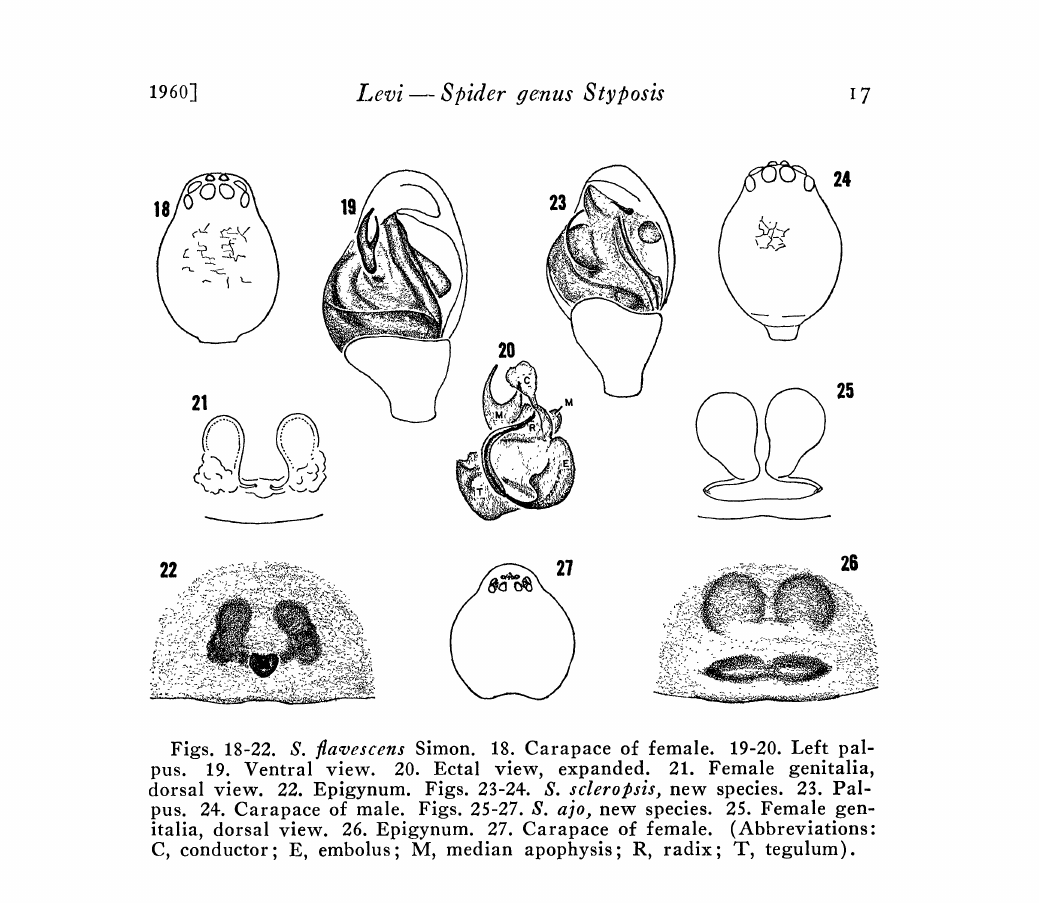
Figs. 18-22. S. flaescens Simon. 18. Carapace of female. 19-20. Left pal- pus. 19. Ventral view. 20. Ectal view, expanded. 21. Female genitalia, dorsal view. 22. Epigynum. Figs. 23-24. S. sclerolsis, new species. 23. Pal- pus. 24. Carapace of male. Figs. 25-27. S. ajo, new species. 25. Female gen- italia, dorsal view. 26. Epigynum. 27. Carapace of female. (Abbreviations" C, conductor; E, embolus; M, median apophysis; R, radix; T, tegulum). Description. Carapace slightly yellowish, otherwise colorless. Six eyes. Anterior eyes one diameter apart. Posterior median eyes one-